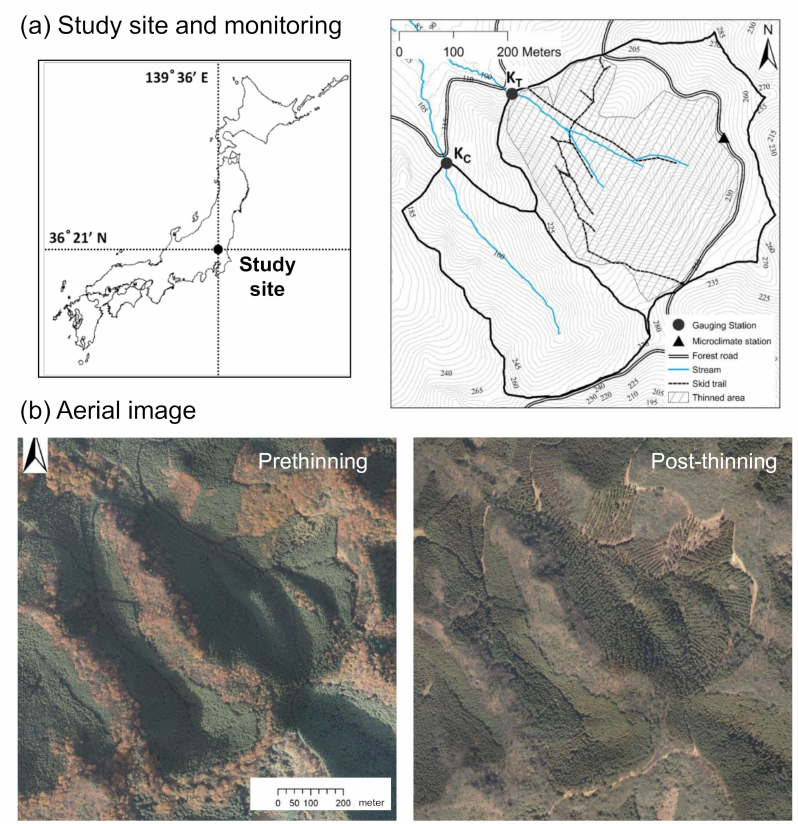
Figure 1. ( a ) Locations of study site and monitoring stations; ( b ) aerial images of study catchments before and after thinning.